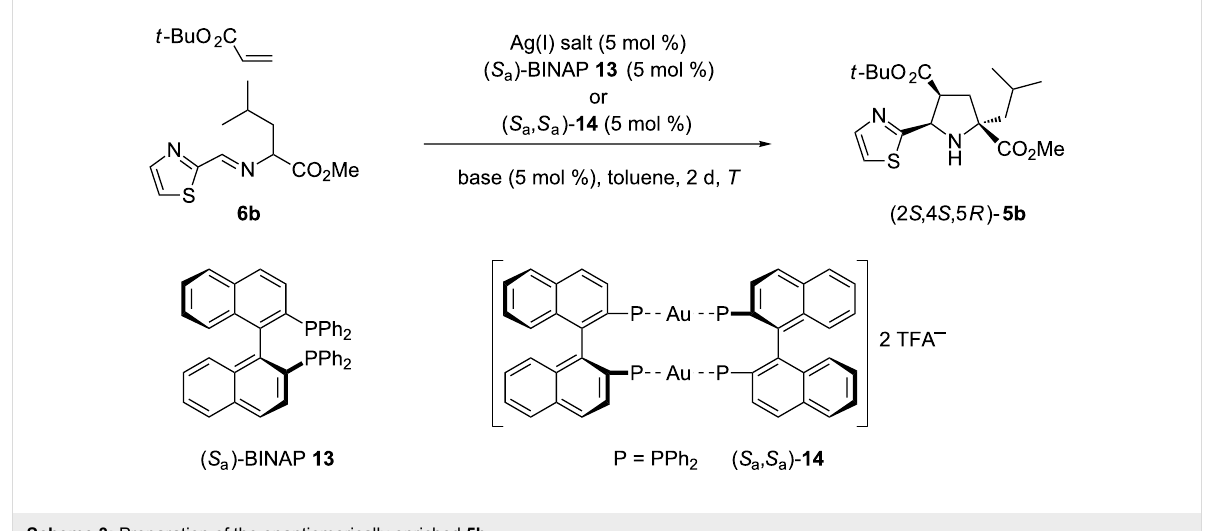
Scheme 3: Preparation of the enantiomerically enriched 5b .